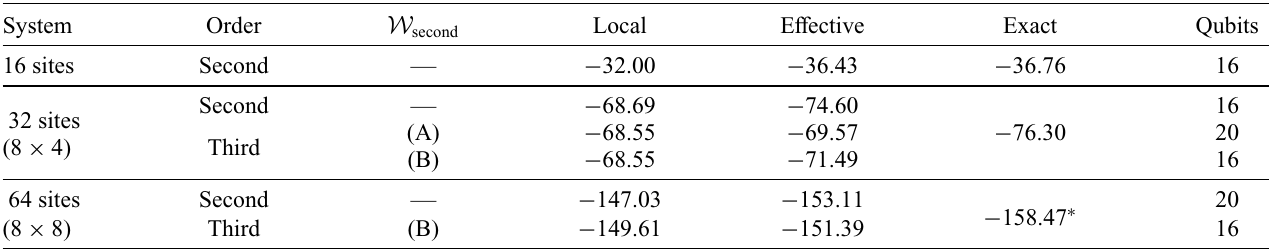
TABLE III. Numerical results for 2D Heisenberg antiferromagnetic systems. “Deep VQE” indicates the results obtained by the proposed scheme. “ W second ” designates the set of local excitations from Eqs. (30) and (31) when we iterate up to the third VQE. where H eff is the effective Hamiltonian used for the last VQE in the protocol. “Effective” means the deep VQE “Local” is given by H eff 00 results of the ground-state energy under the assumption that VQEs are accurate enough, calculated by replacing the VQEs by the exact diagonalization.“Exact” means a ground-state energy obtained by the Lanczos method on the quantum spin simulator QS 3 [61] except for 64 sites, where –158.47* is obtained by the looper quantum Monte Carlo codes in ALPS [62,63]. “Qubits” indicates the number of qubits required through the